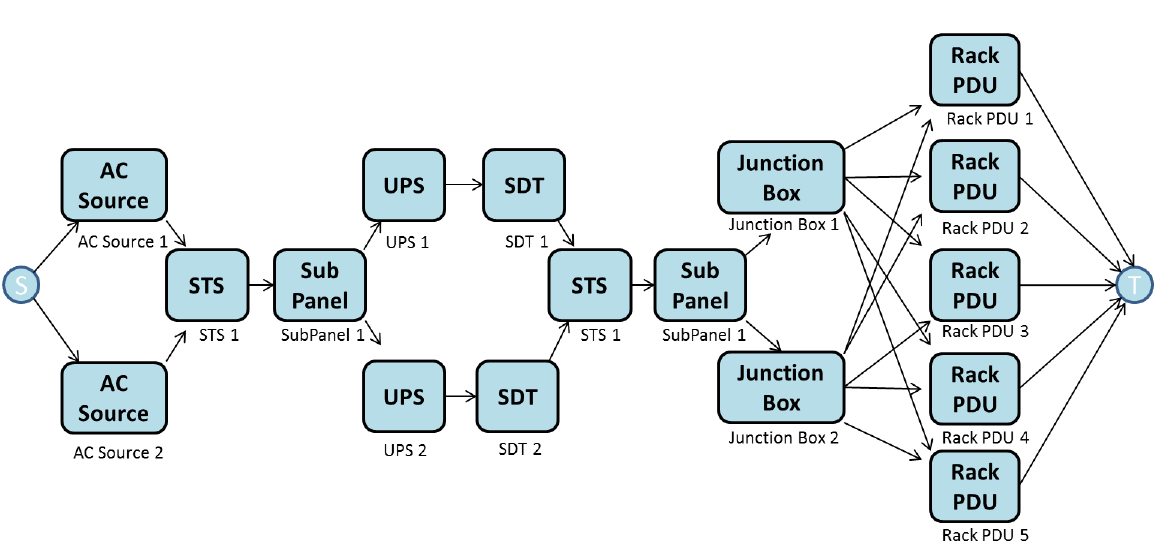
Figure 10. Architecture A5 in the EFM